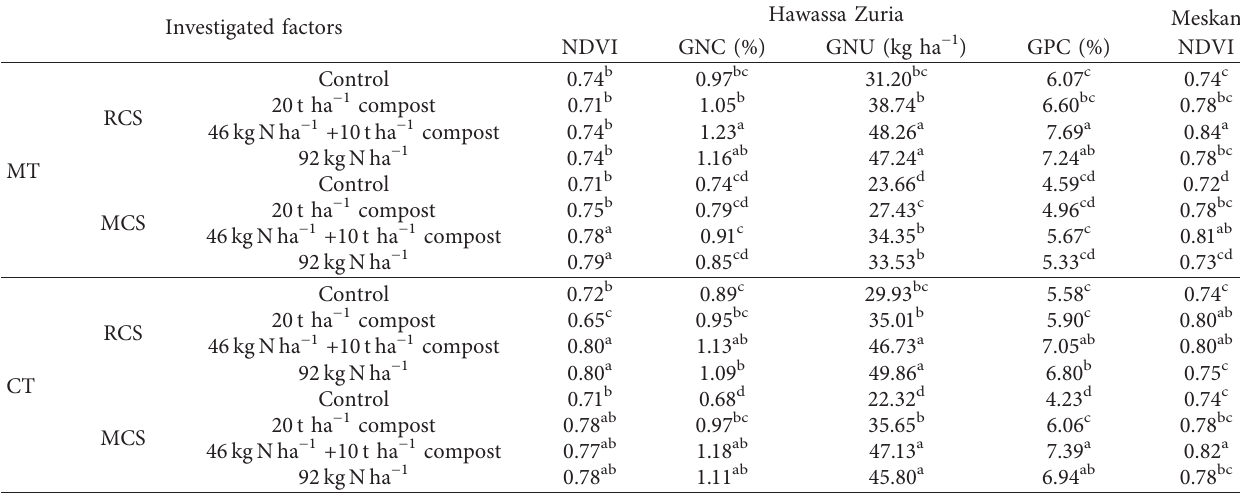
Table 5: Interaction effects of soil tillage, cropping systems, and nitrogen fertilization on NDVI, grain N-content, N-uptake, and protein content of maize grain.